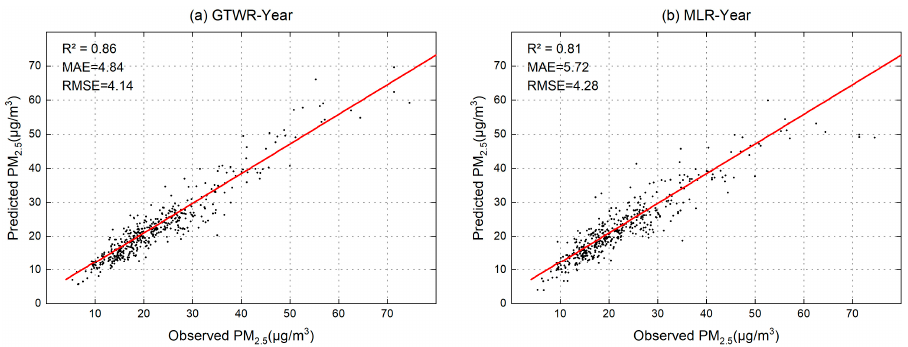
Figure 2. Annual fitting results of GTWR and MLR models. ( a ) GTWR fitting results; ( b ) MLR Figure 2. Annual fi tt ing results of GTWR and MLR models. ( a ) GTWR fi tt ing results; ( b ) MLR fi tt ing fitting results.